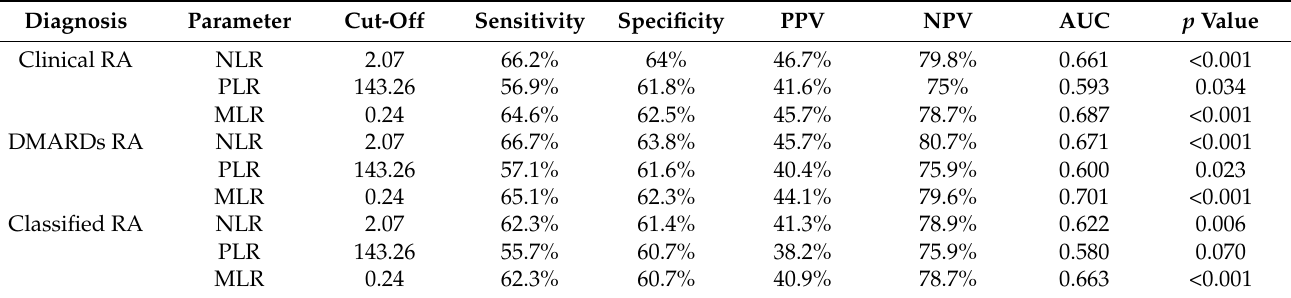
PPV: positive predictive value, NPV: negative predictive value, AUC: area under the curve, DMARDs: disease- modifying anti-rheumatic drugs, RA: rheumatoid arthritis, NLR: neutrophil-to-lymphocyte ratio, PLR: platelet-to- lymphocyte ratio, MLR: monocyte-to-lymphocyte